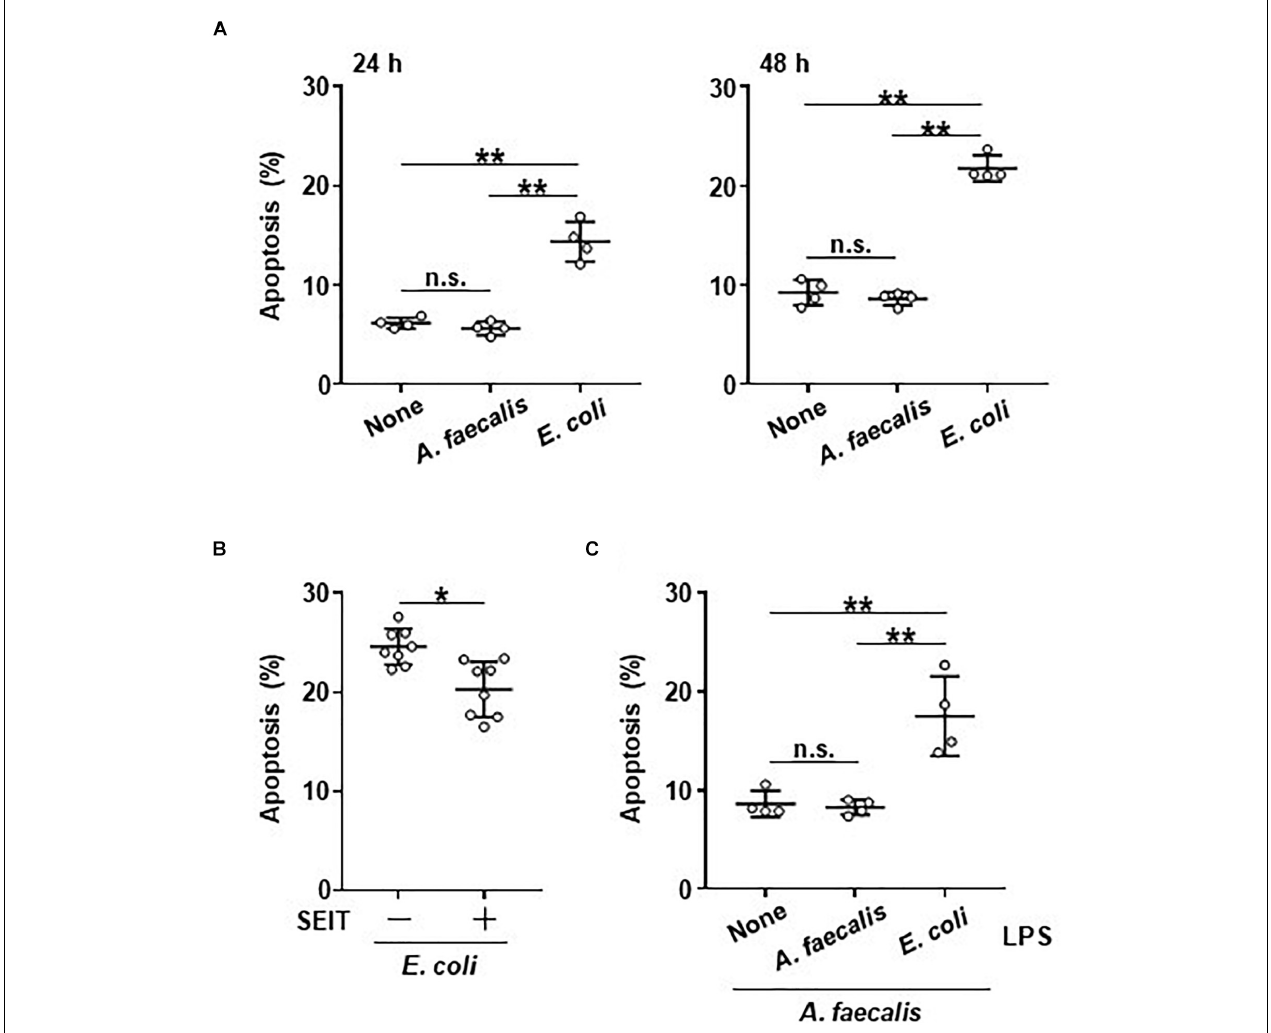
FIGURE 4 | Little induction of apoptotic DCs by A. faecalis. (A) BMDCs were co-cultured without (None) or with live A. faecalis or E. coli at 10 MOI for 24 or 48 h, after which Annexin V + , 7AAD - apoptotic cells were detected by FACS. (B) BMDCs were co-cultured with live E. coli at 10 MOI for 48 h in the absence or presence of iNOS inhibitor SEIT and then apoptotic cells were detected by FACS. (C) BMDCs were co-cultured with live A. faecalis at 10 MOI for 48 h in the absence (None) or presence of A. faecalis LPS or E. coli LPS at 0.1 µ g/ml and then apoptotic cells were detected by FACS. The results shown in (A,C) are representative of two independent experiments. The result shown in (B) is combined from two independent experiments. * P < 0.05; ** P < 0.01; n.s., not significant, which is described in Materials and